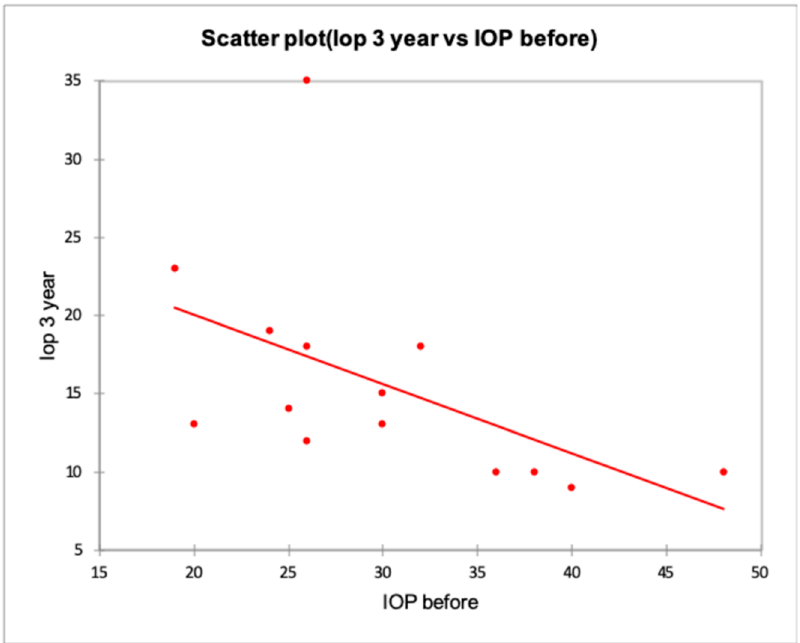
Figure 4. The inverse relationship between the baseline and final IOP values at 36 months. The image showed an inverse relationship between IOP values before and after surgery. Higher IOP at baseline resulted in lower IOP after surgery.